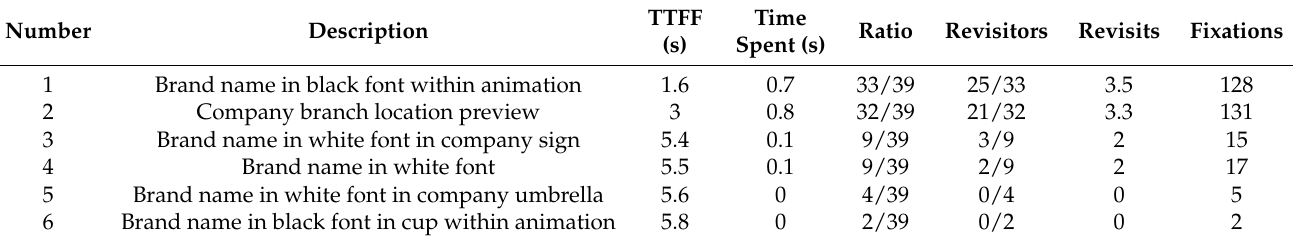
Table A4. New website design: area of interest (AOI) metrics. Note: time to first fixation